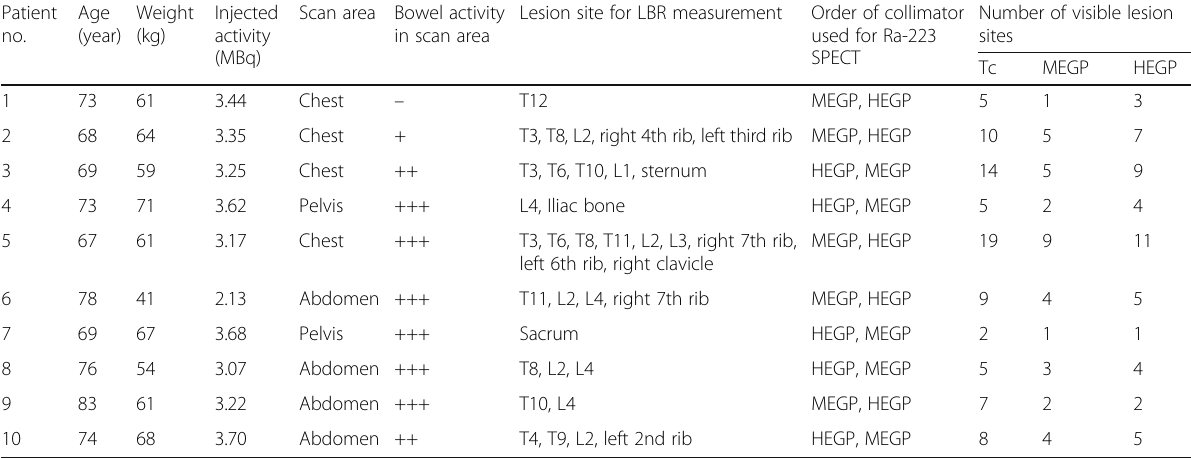
Table 3 Direct comparison of clinical Ra-223 and Tc-99m HMDP SPECT images Patient Age Weight no. (year) (kg)